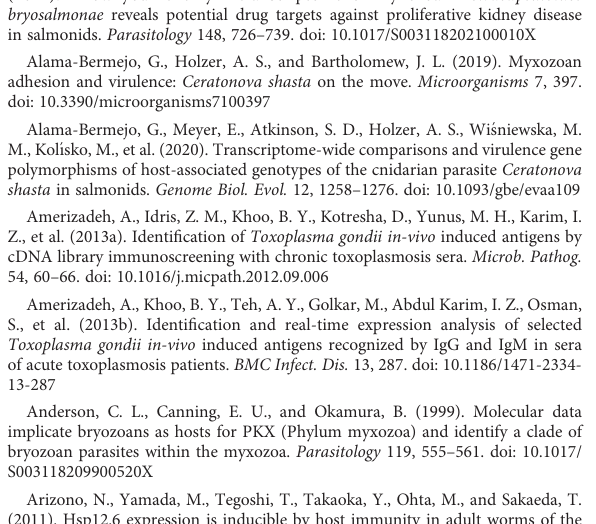
SUPPLEMENTARY FIGURE 1 PCR analysis of identi fi ed recombinant clones. Gel image showing different sized cDNA inserts from in vivo induced positive clones obtained by PCR with vector speci fi c primers. L: 100 bp ladder (Qiagen), Lanes1 – 38PCR-ampli fi edIVIclonesandNTC:negative